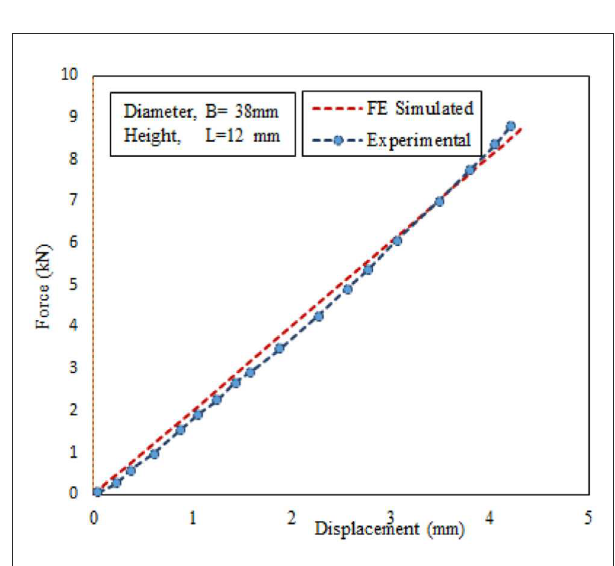
FIGURE2 Load vs. displacement graph for PVA-C model with 15%